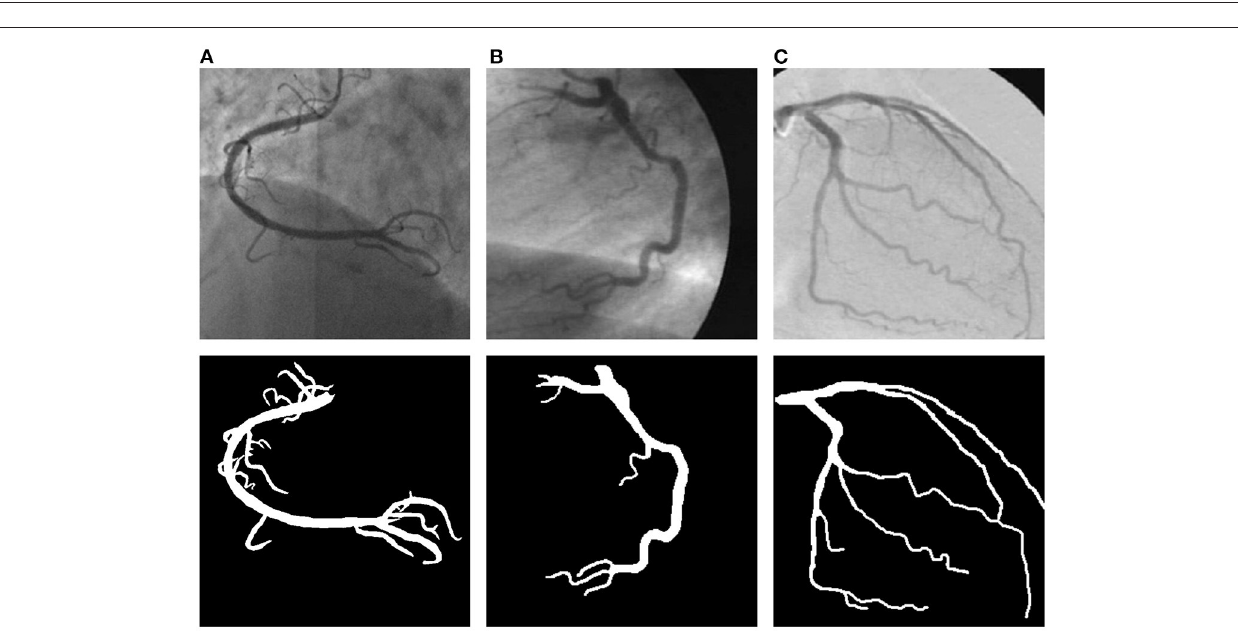
FIGURE 2 | The illustration of the proposed network. We adopt bottleneck residual blocks to replace the internal components of traditional U-Net. The architecture of the bottleneck residual block is shown in Figure 6 . PAM is an attention module and is shown in Figure 7 .